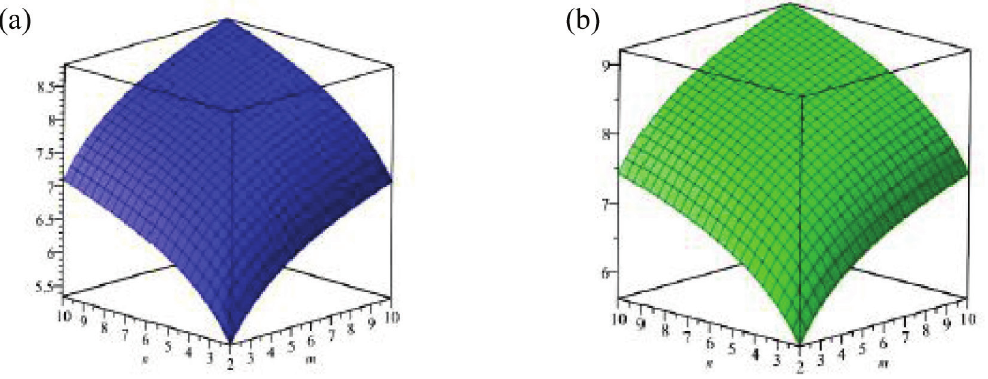
Figure 5: (a) The first Zagreb entropy, (b) the second Zagreb entropy.